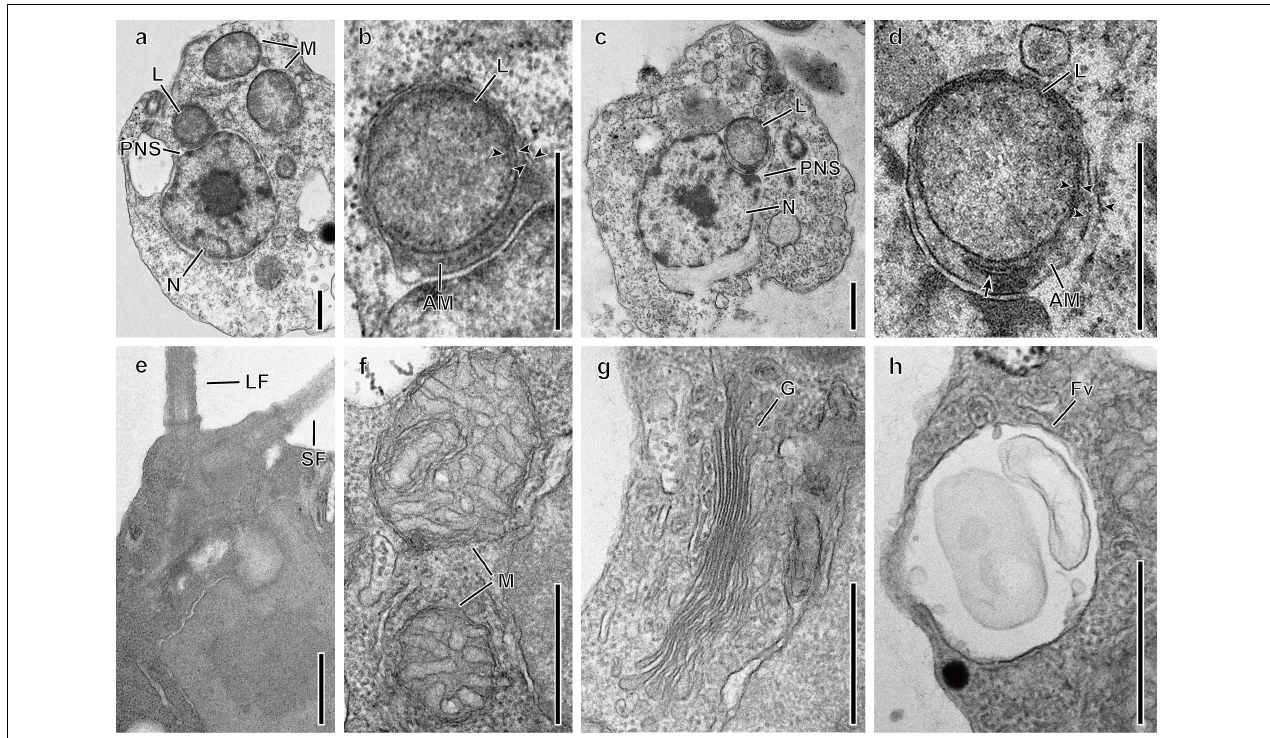
FIGURE 6 | Transmission electron micrographs of Spumella species. (a,b) One leucoplast (L) of S. bureschii Baekdongje012018B8 located in the perinuclear space. (c,d) One leucoplast (L) of S. benthica Hwarim032418A5 located in the perinuclear space. (e) Flagellar apparatus of the long (LF) and short (SF) flagella. (f) Mitochondria with tubular cristae (M). (g) Golgi (G). (h) Food vacuole (Fv). Arrowheads indicate membrane envelops. AM, amorphous mass; PNS, perinuclear space; PR, periplastidial reticulum (arrow). Scale bars = 0.5 µ